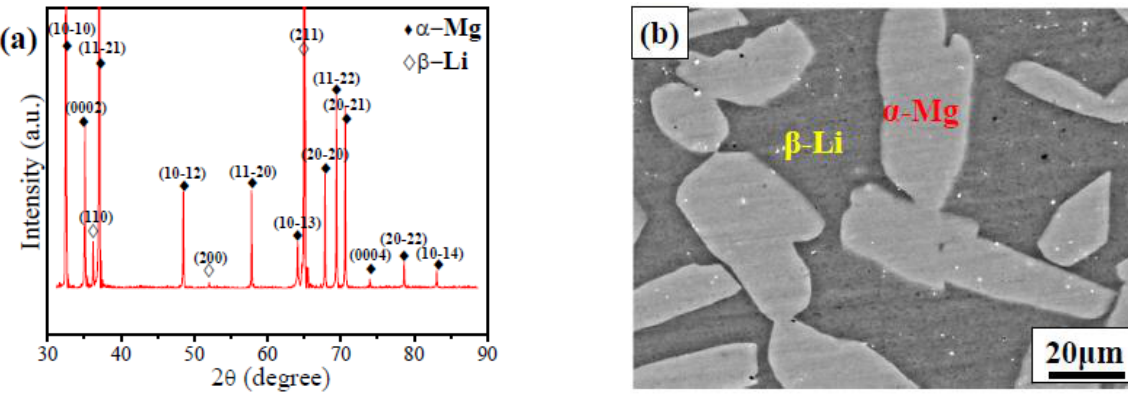
Figure 2. Microstructural characterization of the as-cast Mg–8%Li alloy: ( a ) XRD pattern, ( b ) BSE image.